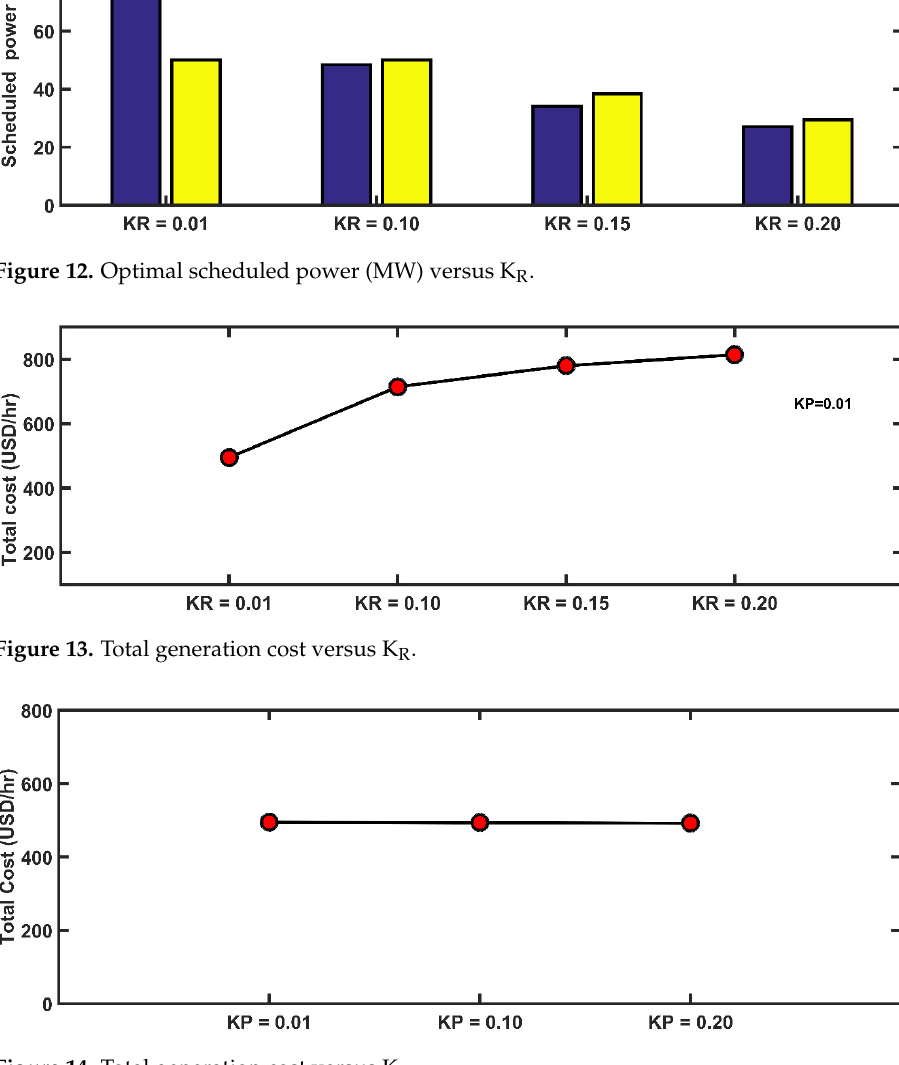
Figure 14. Total generation cost versus K (cid:2900) .